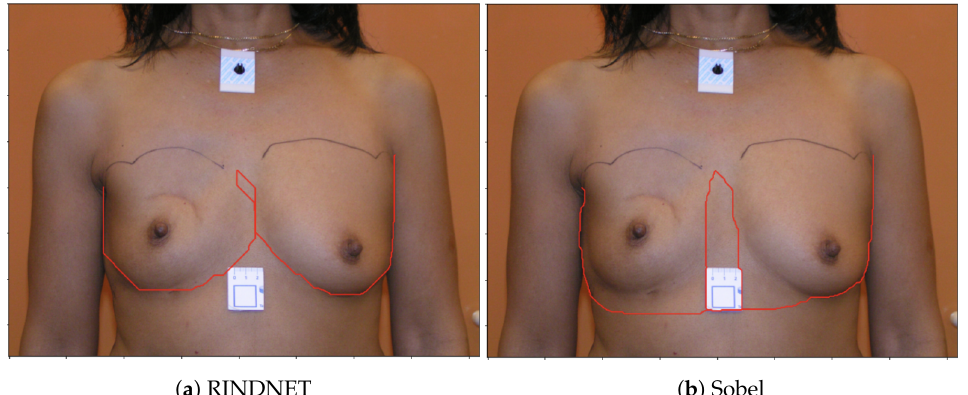
Figure 9. Predicted Breast Contours for shortest-path algorithm using RindNet ( a ) and Sobel ( b ) on the 221 database.